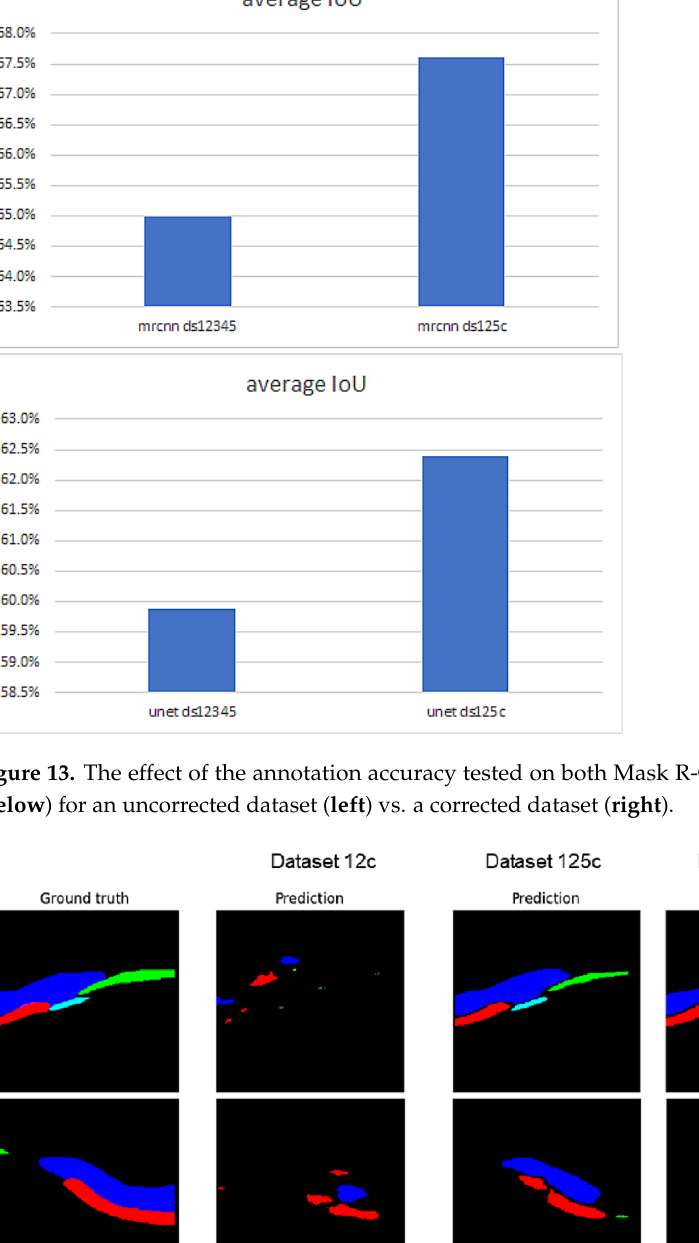
Figure 14. Prediction using the U-NET trained model with different datasets (DS12C, DS125C,